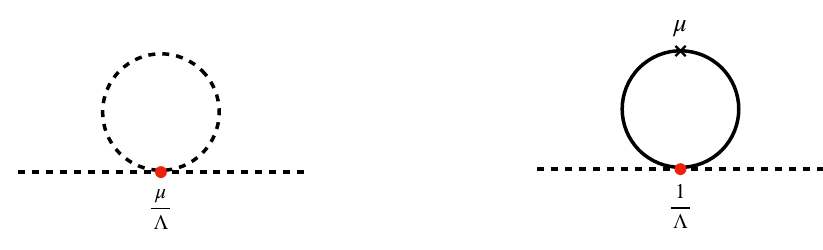
Figure 2 . One-loop thermal corrections to the scalar mass from the scalar (left diagram) and fermionic (right diagram) degrees of freedom in models with non-renormalizable interac- tions (2.6),